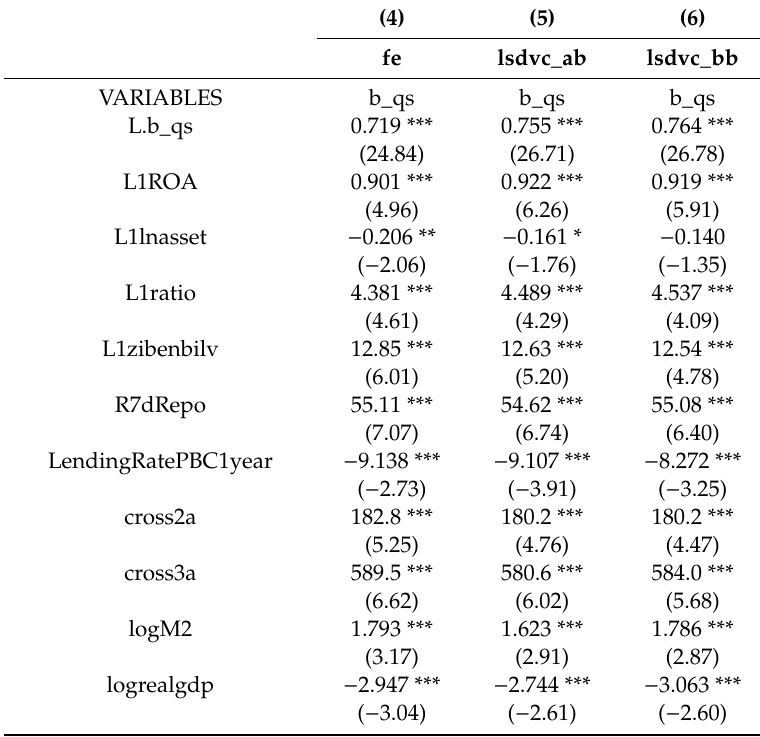
Table 9. Robustness test of Model